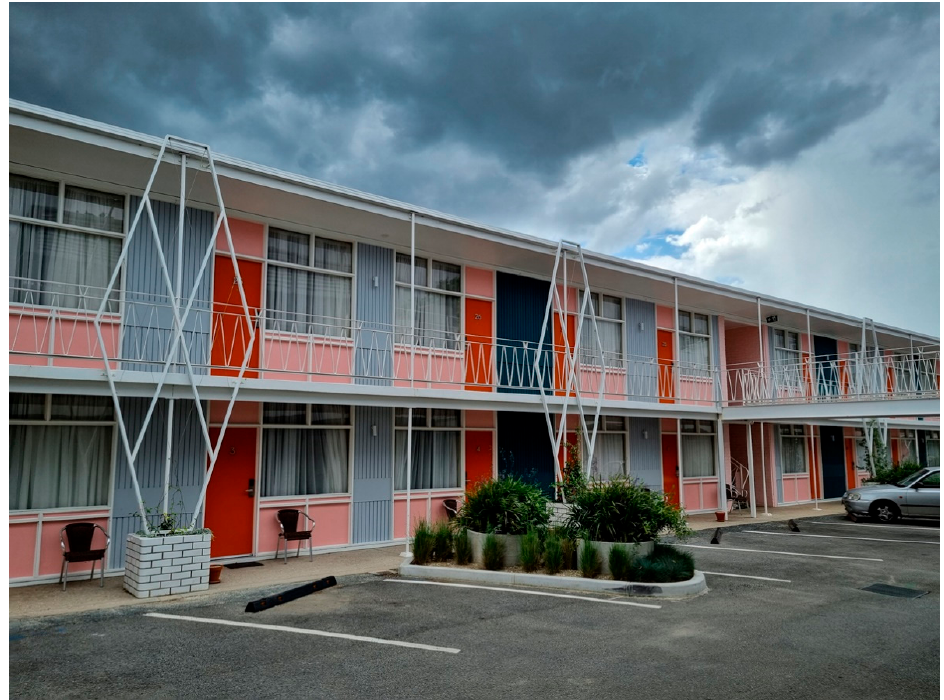
Figure 3. Traditional, 1950s style motel development with external communal circulation spaces.